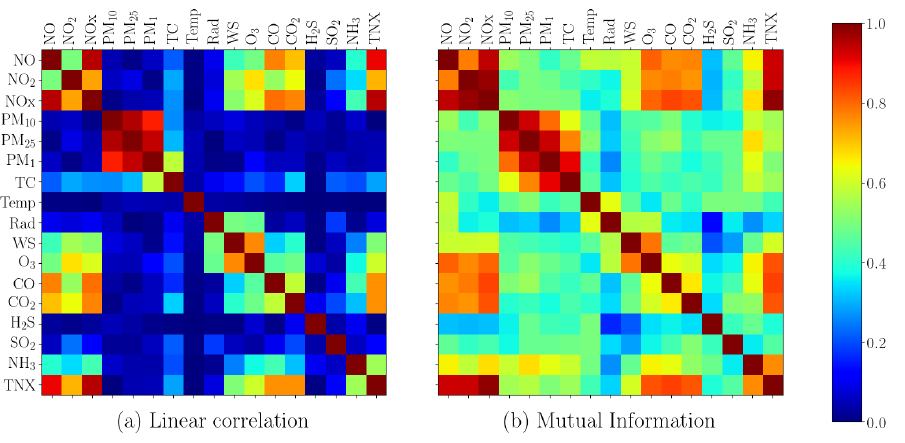
Figure 5. Matrix plot correlation analysis between ozone (O 3 ) and other measured variables. It can be seen that linear correlation (a) does not capture well the relationship between O 3 and other measured variables, such as m , p -xylene (TNX), NO and